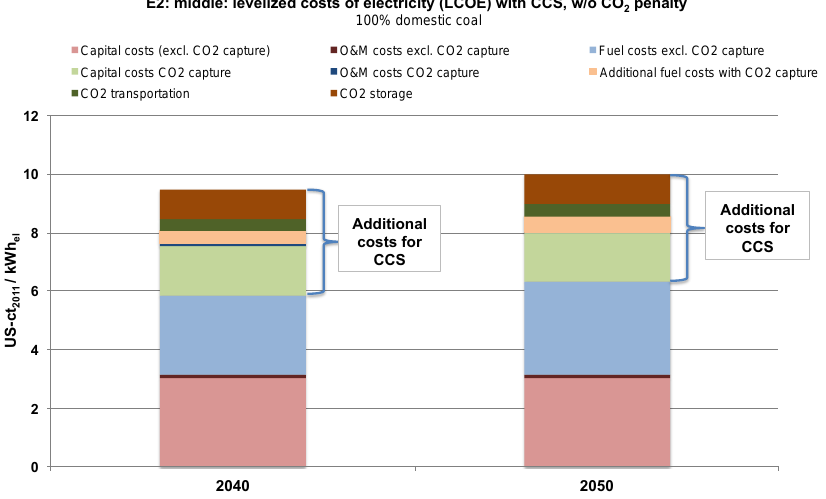
Figure 5. Additions to LCOE in South Africa resulting from CCS by cost category in coal development pathway E2: middle without CO 2 costs.